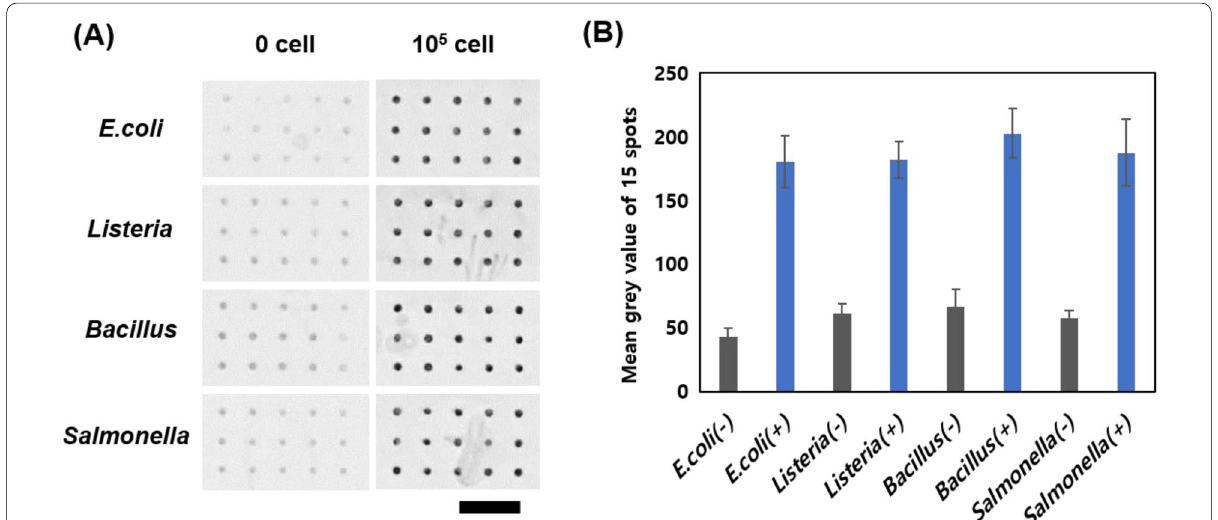
Fig. 4 A Grey capture images of array spots formed on the COC chip to detect four pathogenic genes. Scale bar is 4 mm. B Bar graph of the grey values of ( A ) images analyzed using Image J software. The symbol (